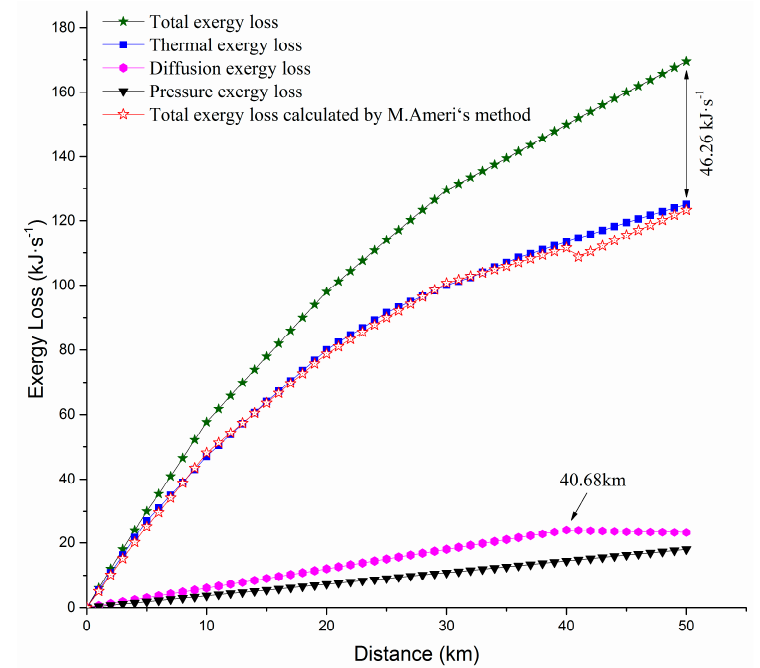
Figure 3. The axial distribution curve of exergy losses.